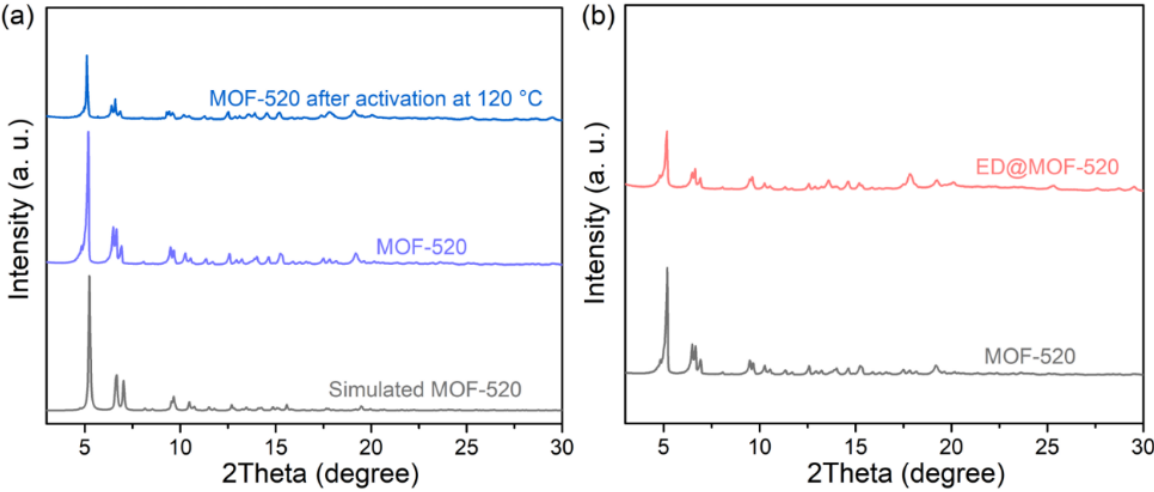
Figure 2. ( a ) PXRD patterns of MOF-520, MOF-520 after activation at 120 °C and simulated one from crystal structure data of MOF-520, ( b ) PXRD patterns of MOF-520 and all ED@MOF-520.